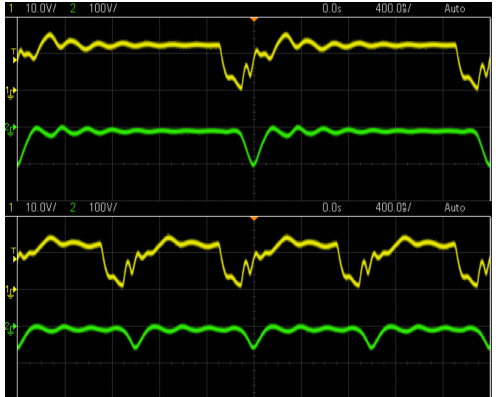
Figure 7. Voltage pulses obtained with voltage of 4 V, a separation of 1 mm between electrodes, frequency of 500 kHz (upper) and 1 MHz (lower) in drinking water. The yellow line represents the action of the driver and the green line the voltage in the